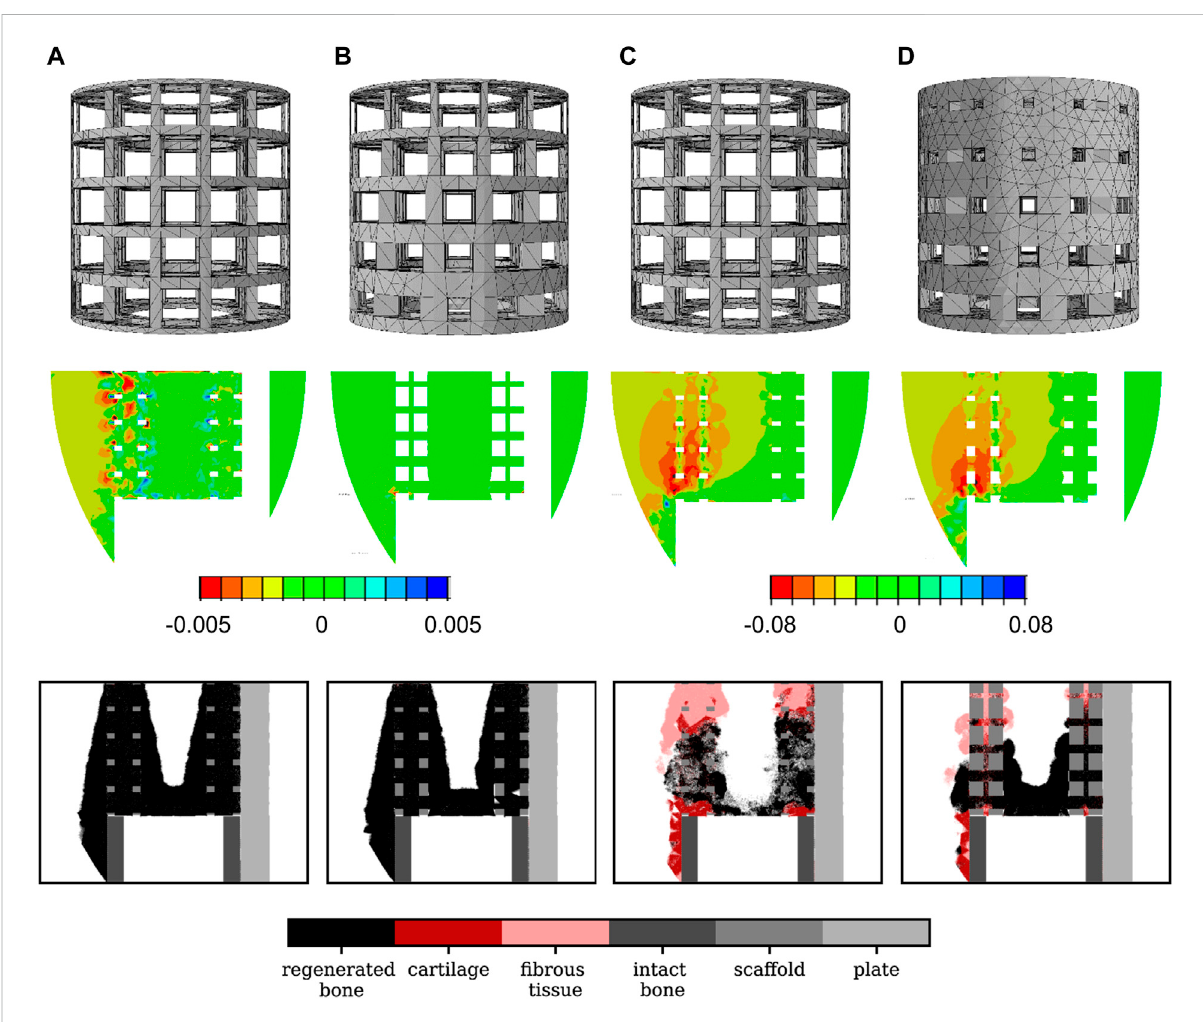
FIGURE 4 Scaffolddesign,initialabsoluteprincipalstraindistributioninthemid-sagittalplaneand24-weekhistologypredictionsinthemid-sagittalplane for different scaffold designs: (A) optimal titanium scaffold design; (B) a good titanium graded design (X 1 (cid:1) 1 . 84mm X 2 (cid:1) 3 . 45mm, X 3 (cid:1) 2 . 26mm); (C) scaffold design optimized for titanium but now made of soft material; (D) optimal soft material scaffold